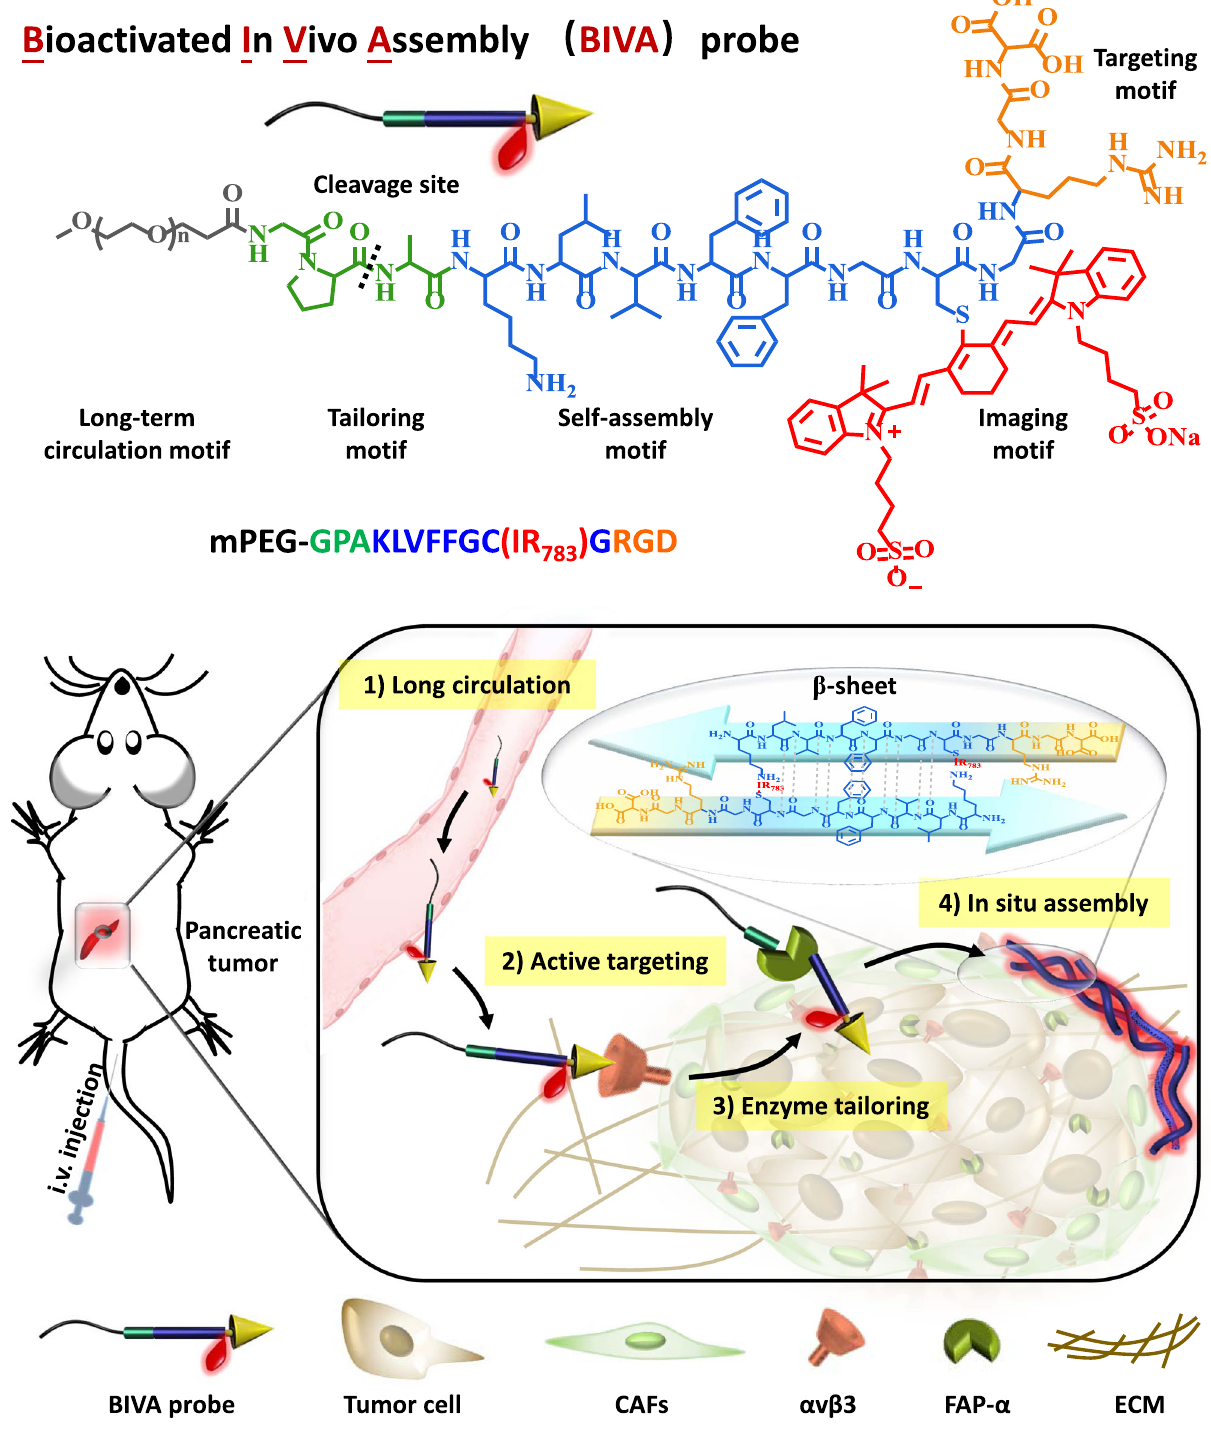
Fig. 1 Chemical structure of bioactivated in vivo assembly (BIVA) probe. The long-term circulation property of BIVA probe offered more opportunity for active targeting. Then, the enzyme (FAP- α ) on the surface of tumor cell speci fi cally tailored the probe and induced in situ nano-assemblies. The β -sheet assemblies exhibited a site-speci fi c location around the tumor cell and a prolonged accumulation for better pancreatic tumor intraoperative Table 1, CD spectrum of M3 assemblies had a positive band at λ = 193 nm and two negative bands at λ = 208 nm, and λ = 225 nm respectively, which implied a β -sheet and α -helix hybrid structure. In contrast, under the same concentration, M1 molecules had a random coil secondary structure in CD spectrum as monomers which the concentration is lower than CAC. The